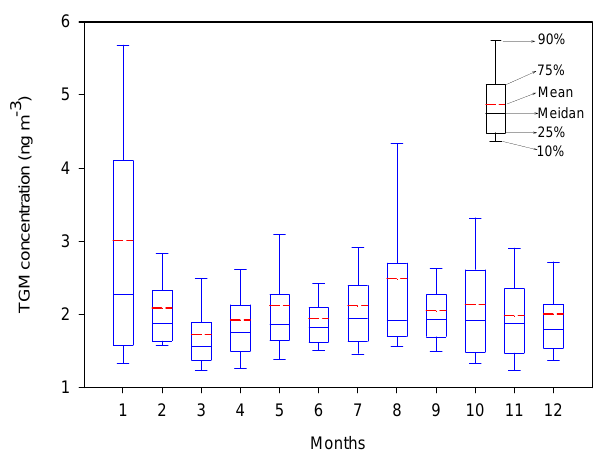
Fig. 8. Monthly variations of TGM concentrations in ambient air at Mount Waliguan Observatory